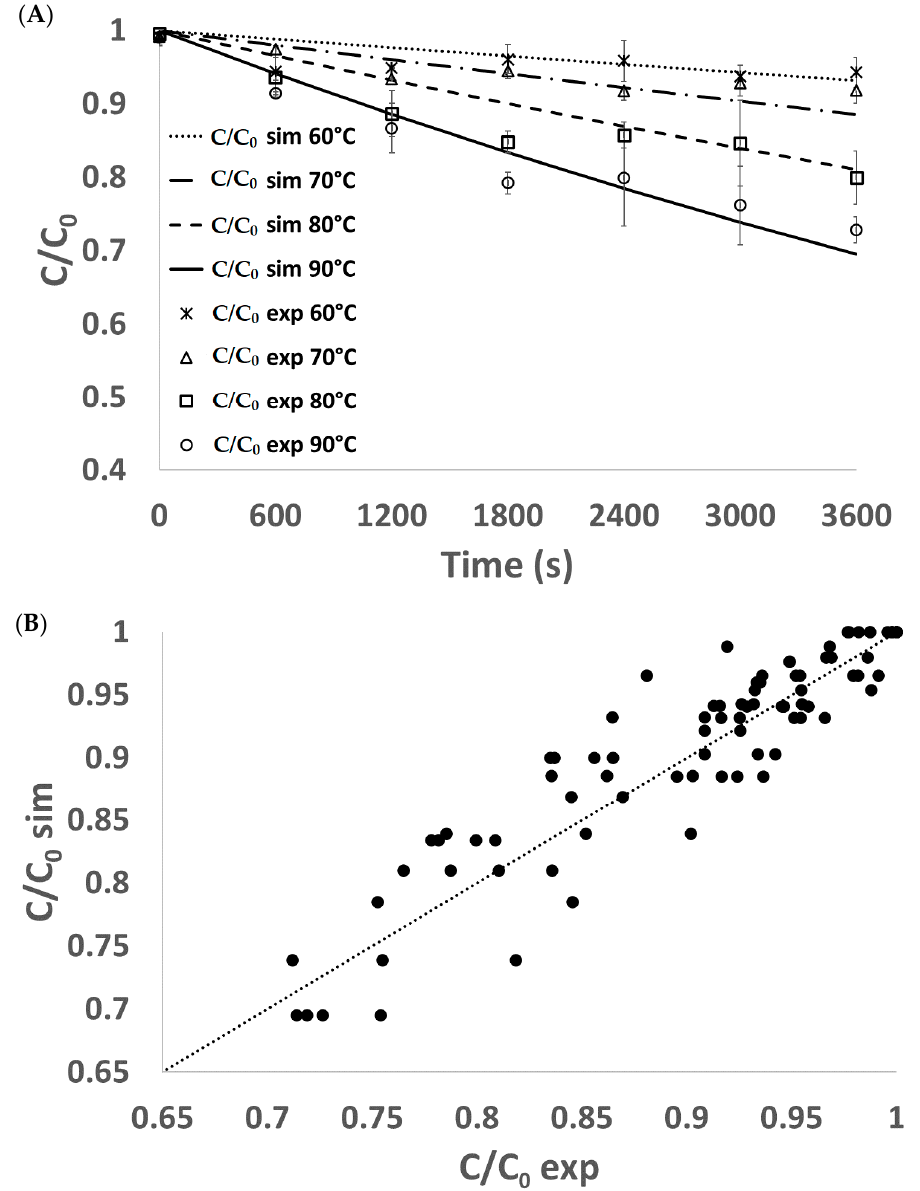
Figure 1. Time course of intrinsic betacyanin (C/C 0 ) heated at different temperatures ( A ). Solid